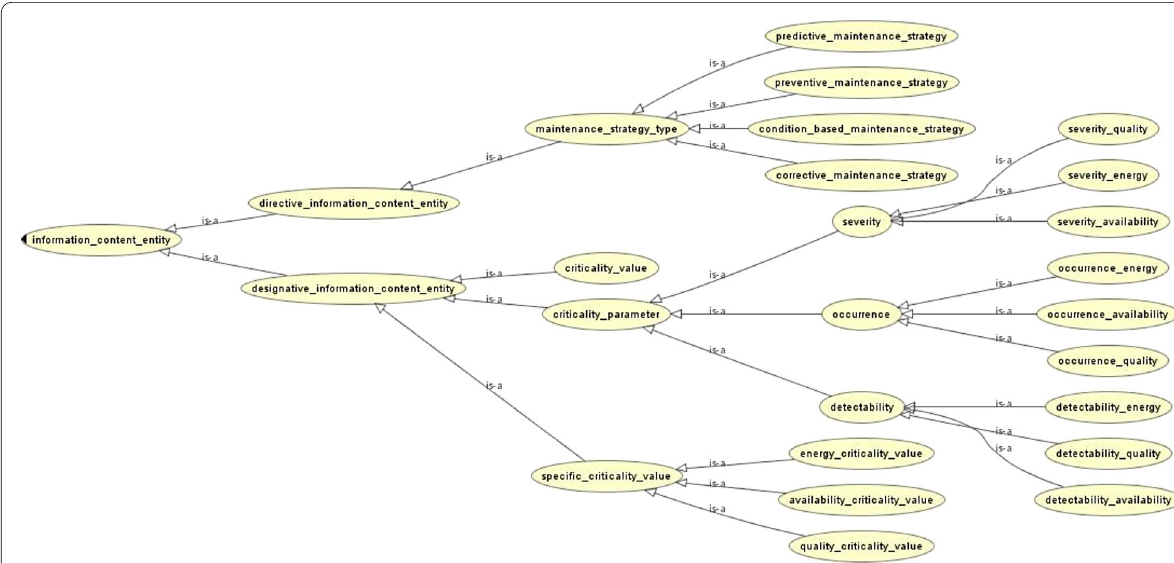
Figure 6 Taxonomical view of MOCA